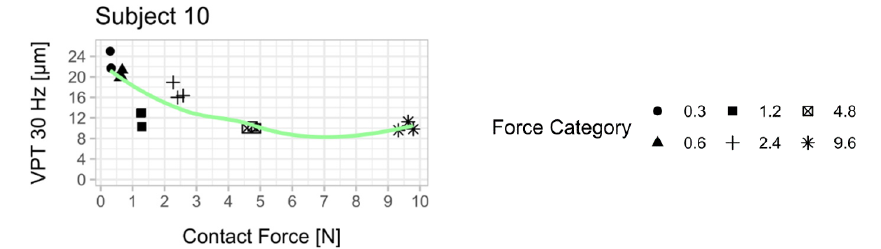
Figure 3. Relationship between vibration perception thresholds (VPT) at 30 Hz and contact force for each subject. Each scatter plot shows the three determined VPTs for each contact force condition. A smoothed conditional mean was added using the R function “geom_smooth ()” in combination with the argument “method = loess”. All 10 subjects showed a reduction in VPT with increasing contact force. The mean from the respective three VPT measurements per contact force was used for statistical analysis (Figure 4). An attempt was made to establish a psychophysical relationship between the contact force and the perceived sensitivity across all subjects (Appendix B, Figure A2).